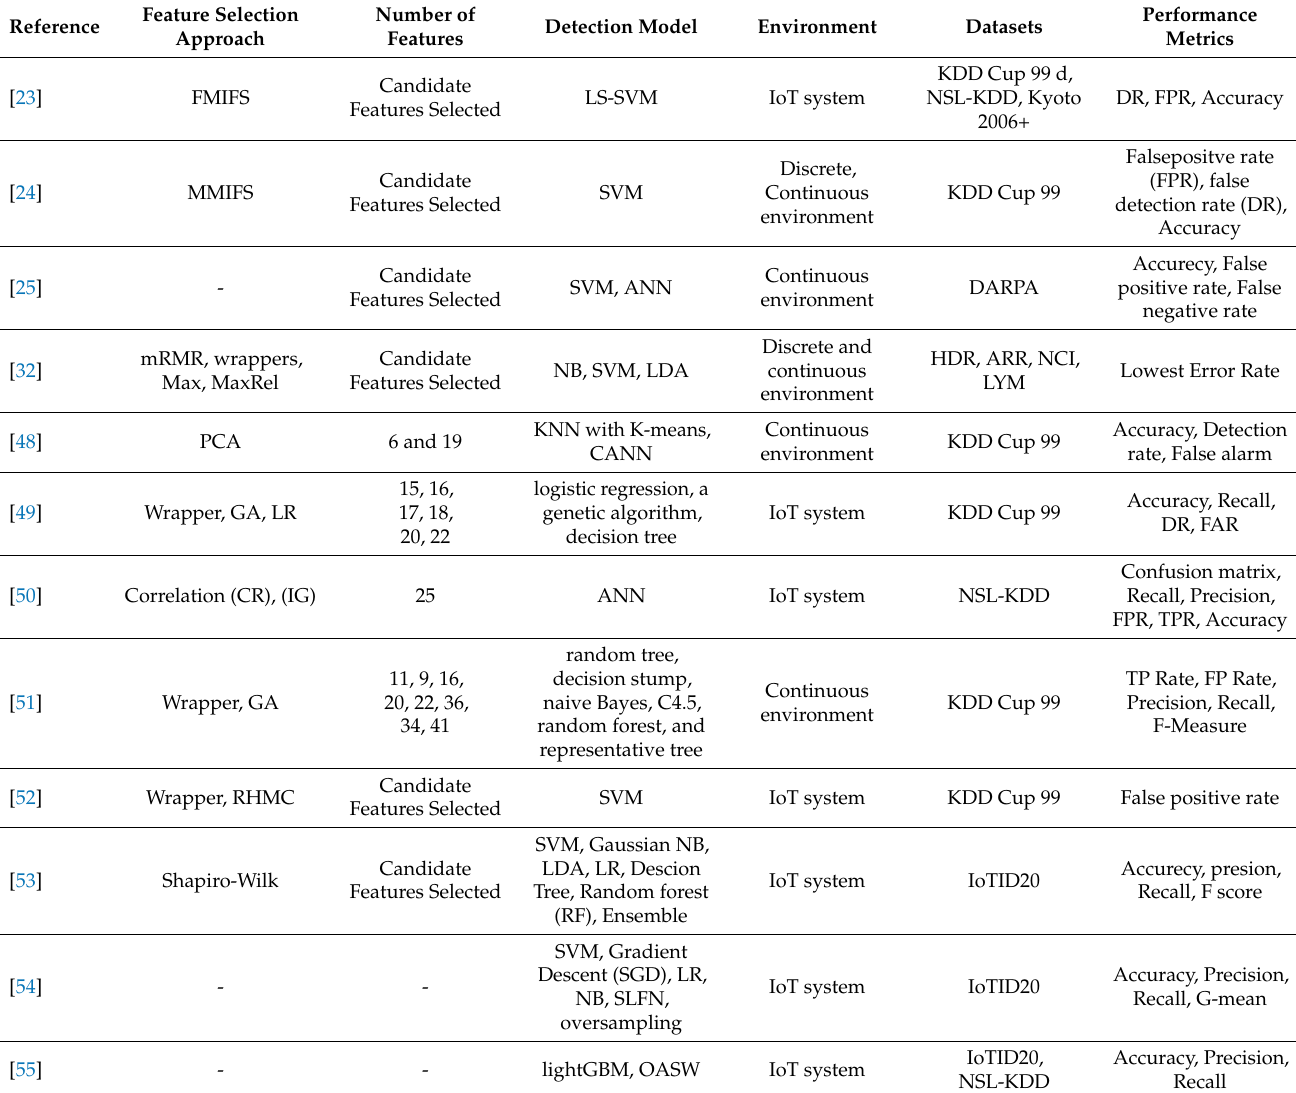
Table 1. Summary of different feature selection